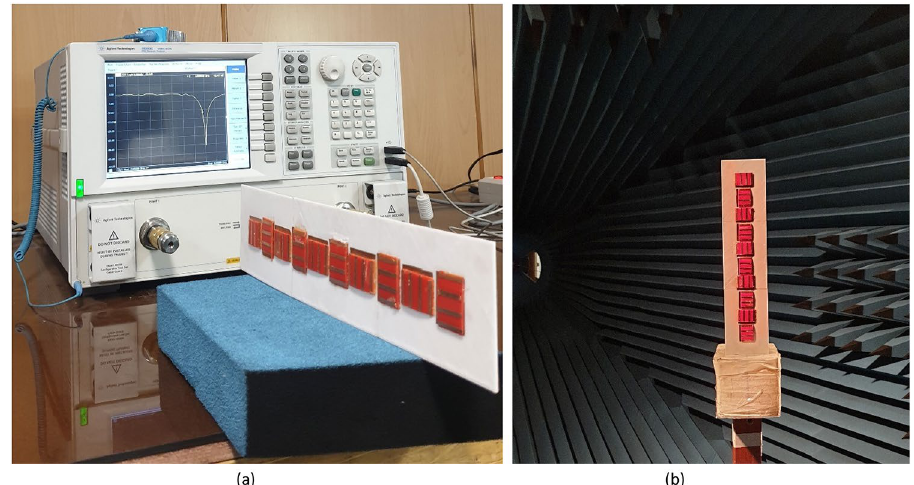
Figure 10. Measurement setup for ( a ) reflection coefficients, ( b ) radiation patterns.